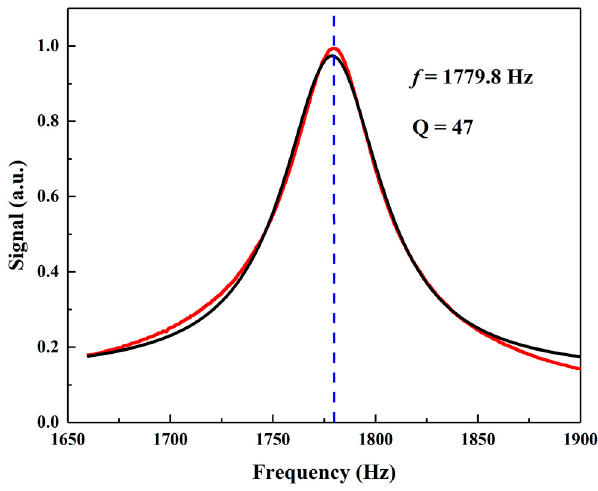
Figure 8. Resonance frequency response curve (red data-points) of the gold-plated photoacoustic cell in N 2 at atmospheric pressure and room temperature and Lorentzian fit (black line). The lock-in amplifier integration time was set to 1 s.